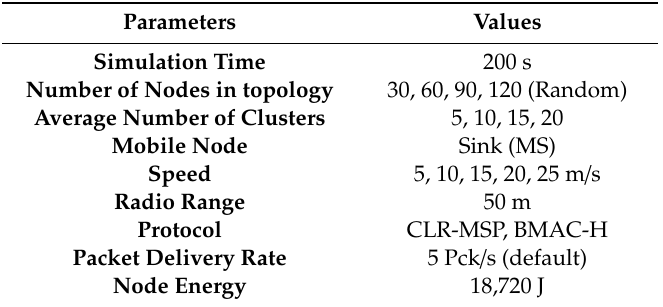
Table 1. Simulation